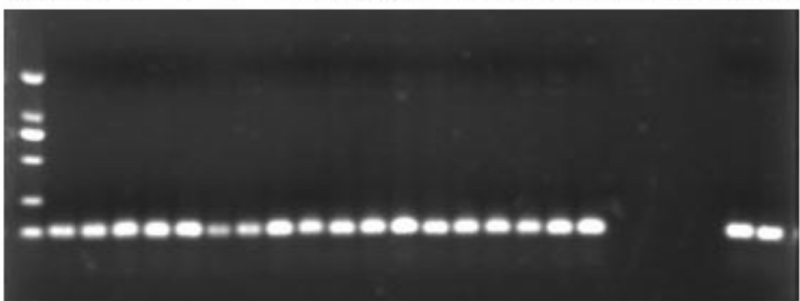
Figure 4. qPCR amplicons (116 bp) from the 18 water samples: lane M, DL 2000 Maker; lanes 1–18 the 18 water samples; lane 19 and 20, the negative control; lane 21 and 22, no template control; lane 23 and 24 the positive